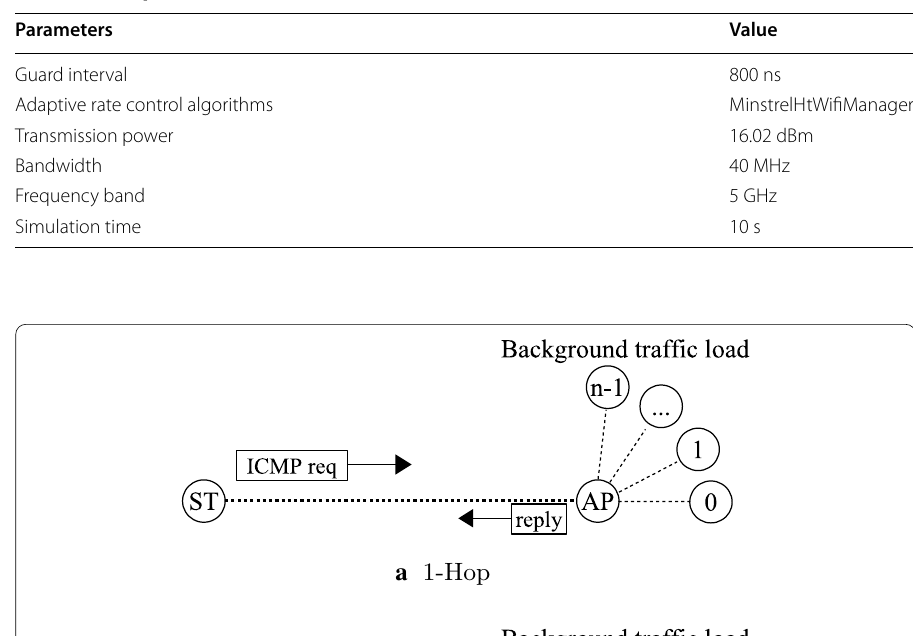
Table 1 NS3 parameters